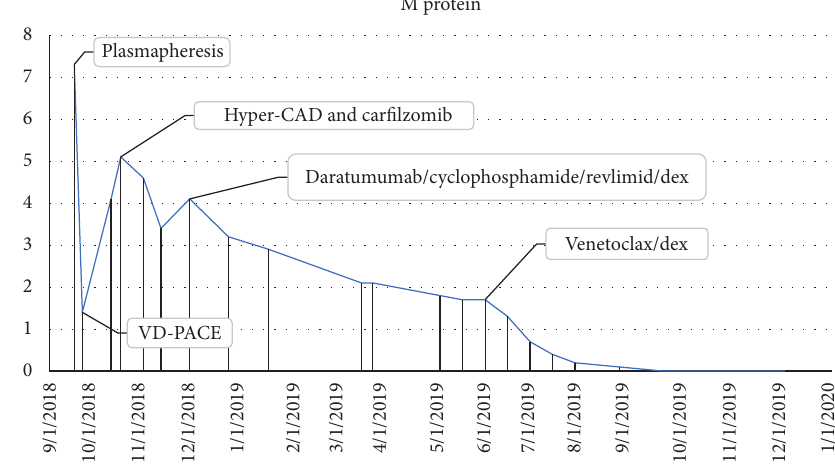
Figure 5: Serum monoclonal proteins.